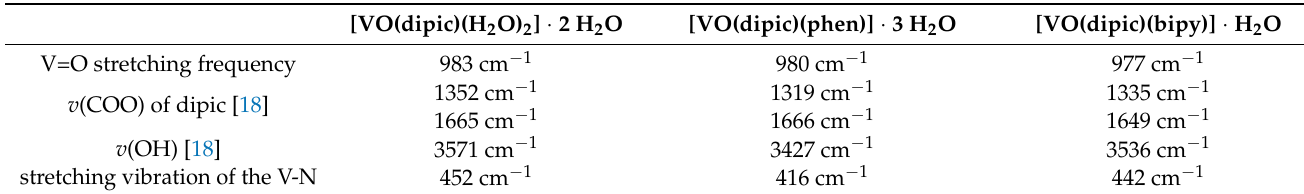
Table 3. IR data of [VO(dipic)(H 2 O) 2 ] · 2 H 2 O, [VO(dipic)(phen)] · 3 H 2 O, [VO(dipic)(bipy)] · H 2